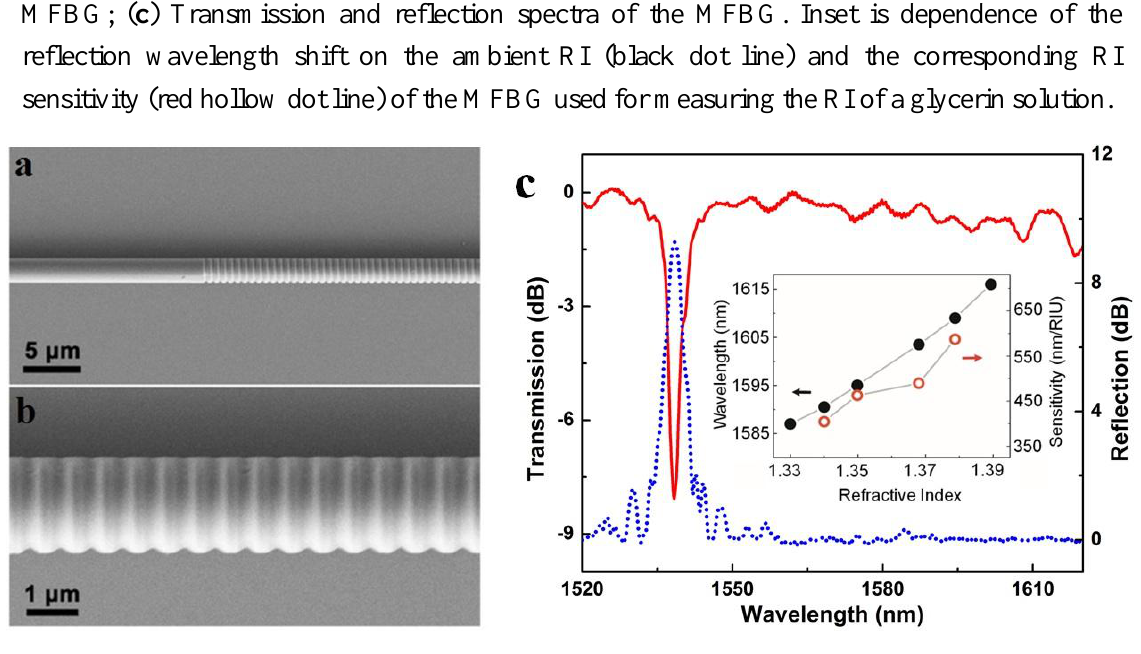
Figure 9. microfiber Bragg gratings (MFBG) [42]. ( a ) Scanning electron microscope